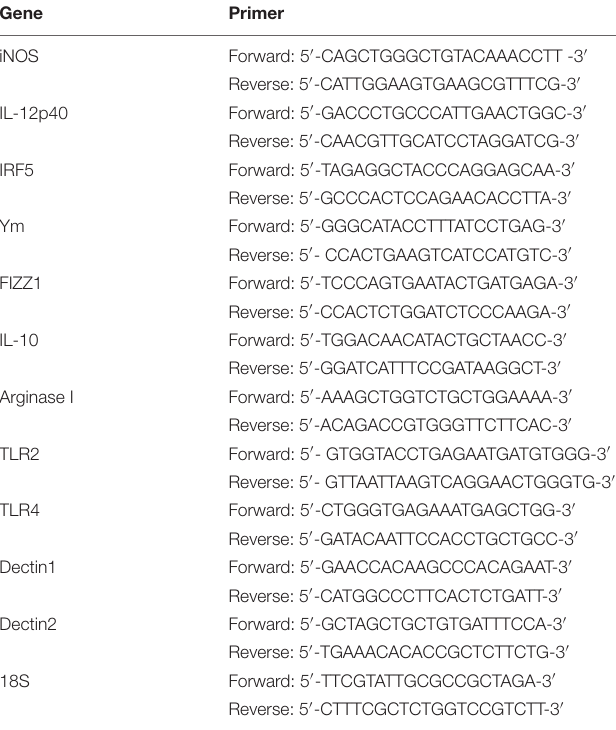
TABLE 1 | Primers for the specific genes used in the qPCR